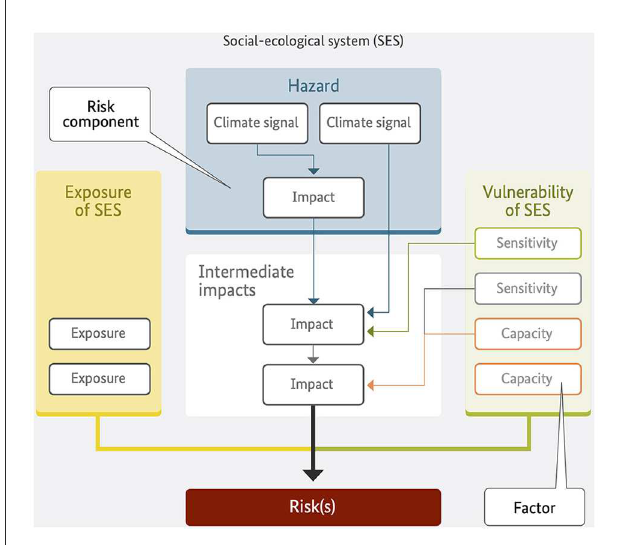
FIGURE1 Structure and elements of an Impact Chain. Source: Hagenlocher et al. (2018). With kind permission of K. Renner, EURAC. Climate risk results from the interaction of the risk components vulnerability, exposure, and hazard (IPCC, 2014). Risk components are subdivided into (risk) factors: Factors of the hazard under consideration are climate signals and direct physical impacts, exposure factors are one or more entities exposed to the hazard, vulnerability factors are sensitivities and capacities of these exposed entities (GIZ and EURAC, 2017). “Intermediate impacts are not a risk component by themselves but merely an auxiliary tool to fully grasp the cause-effect chain leading to the risk” (GIZ and EURAC, 2017), including cascading effects like propagation of infrastructure failure.